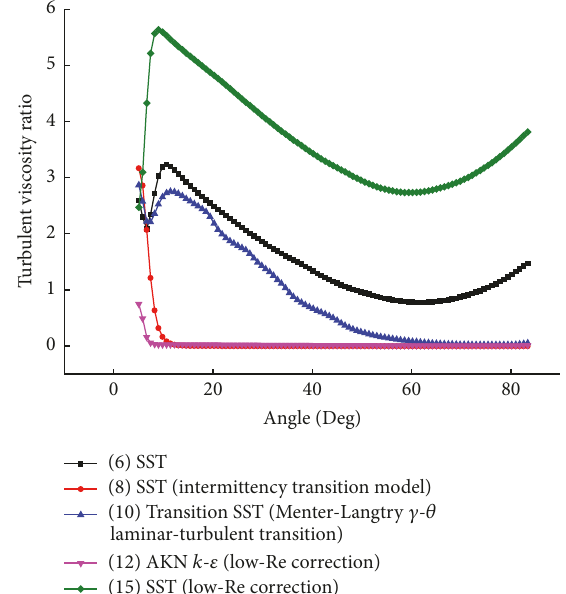
Figure 11: Turbulent viscosity ratio in center